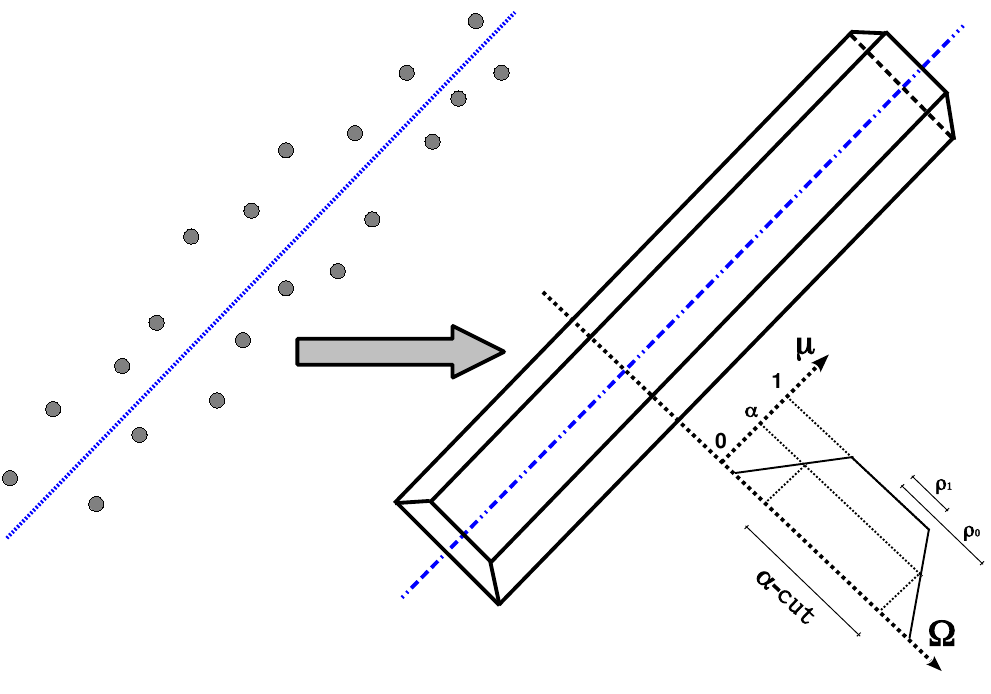
Figure 8. Scatter of points and fuzzy segment representing its uncertainty with a trapezoidal fuzzy